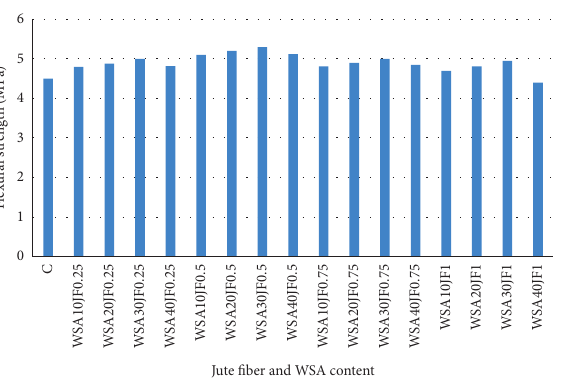
Figure 9: Flexural strength of mixture containing WSA and jute fiber.